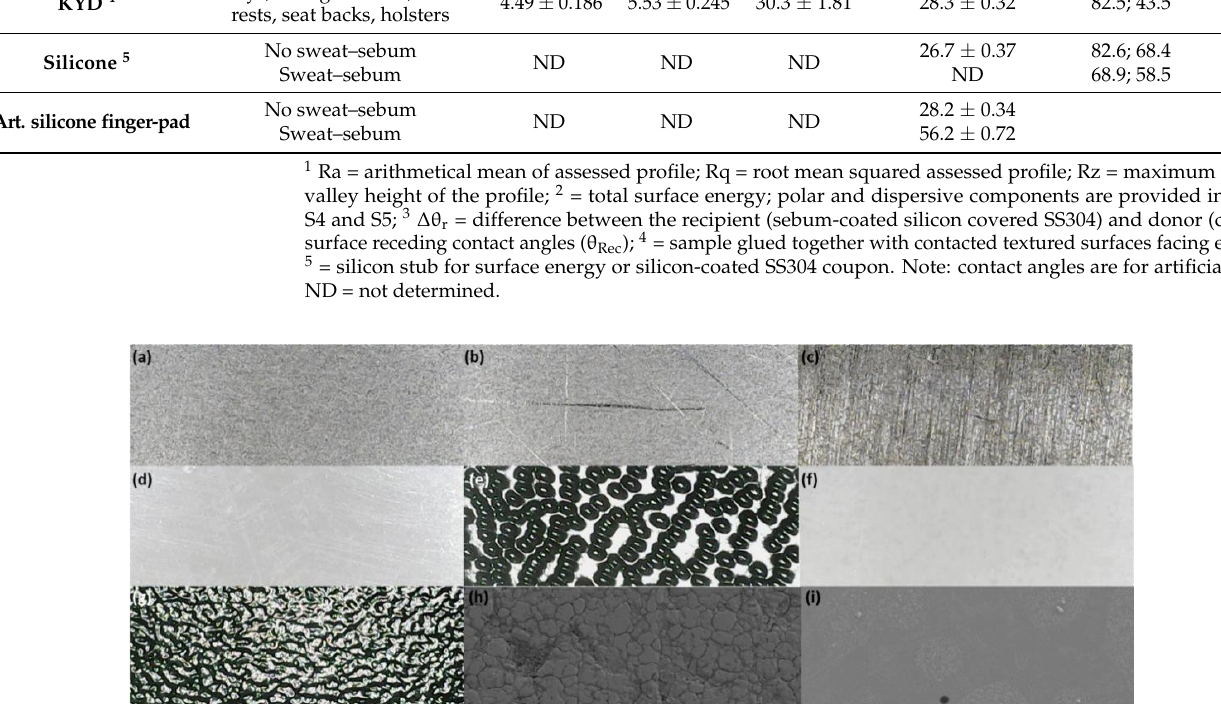
Figure 1. Microscopic analysis of coupon material surface textures. Light microscopy at × 20 magnification: ( a ) unscratched SS304, ( b ) scratched SS304, ( c ) aluminum 5251 alloy, ( d ) ABS smooth surface, ( e ) ABS pinseal texture, ( f ) melamine laminate, ( g ) KYDEX ® haircell texture, and SEM microscopy at × 1000 magnification. ( h ) SS304 showing surface complexity ( × 1000 magnification) and ( i )